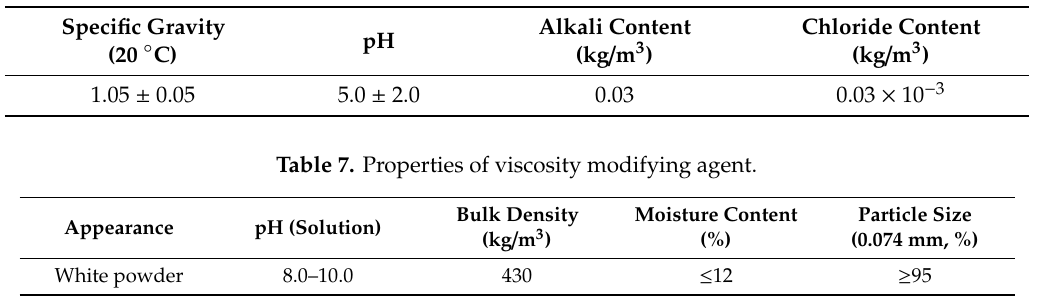
Table 6. Properties of superplasticizer.